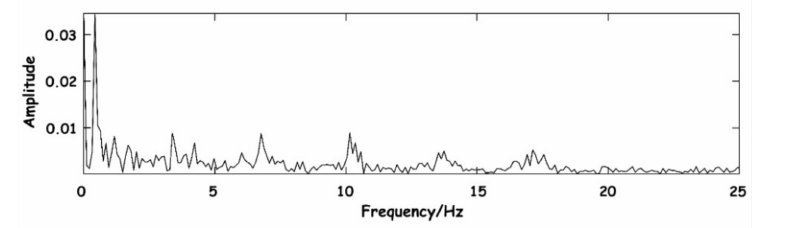
Figure 6. DB5 wavelet base function.